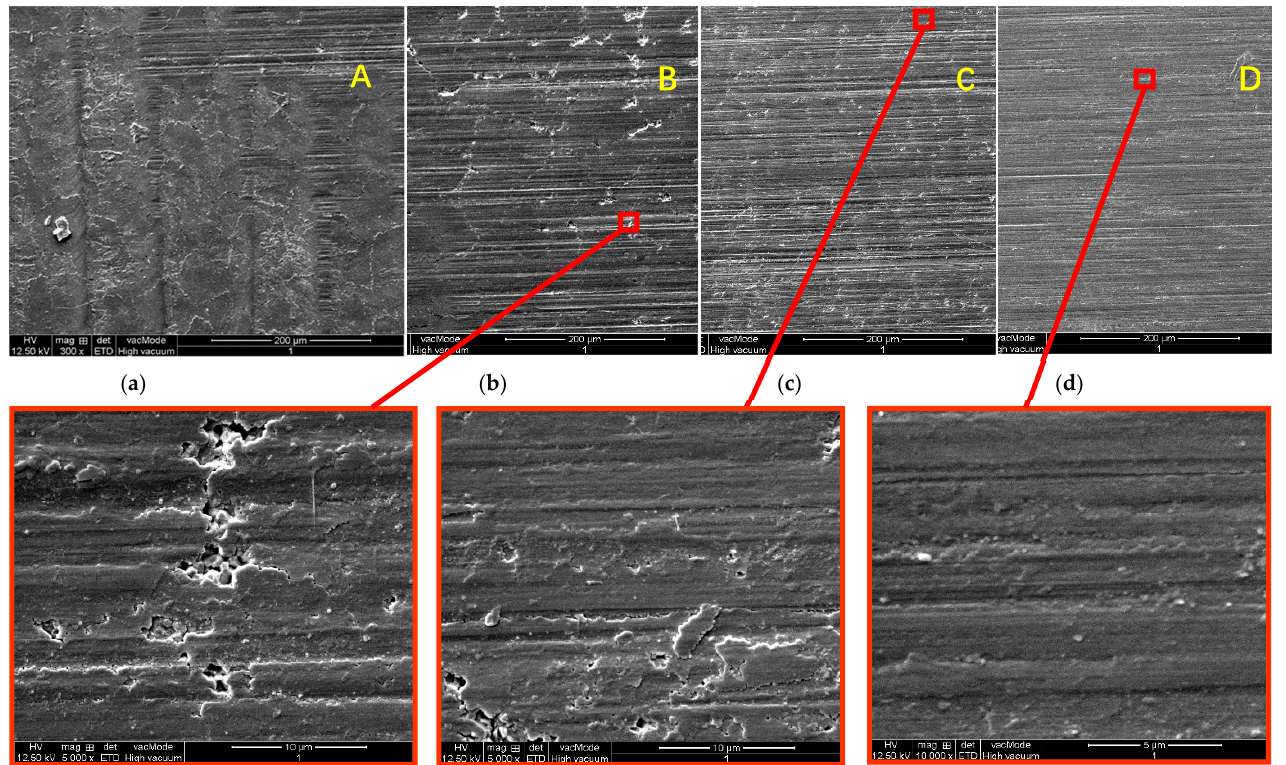
Figure 13. Micromorphology of the workpiece produced by high-speed grinding. ( a ) Surface A . ( b ) Surface B . ( c ) Surface C. ( d ) Surface D.